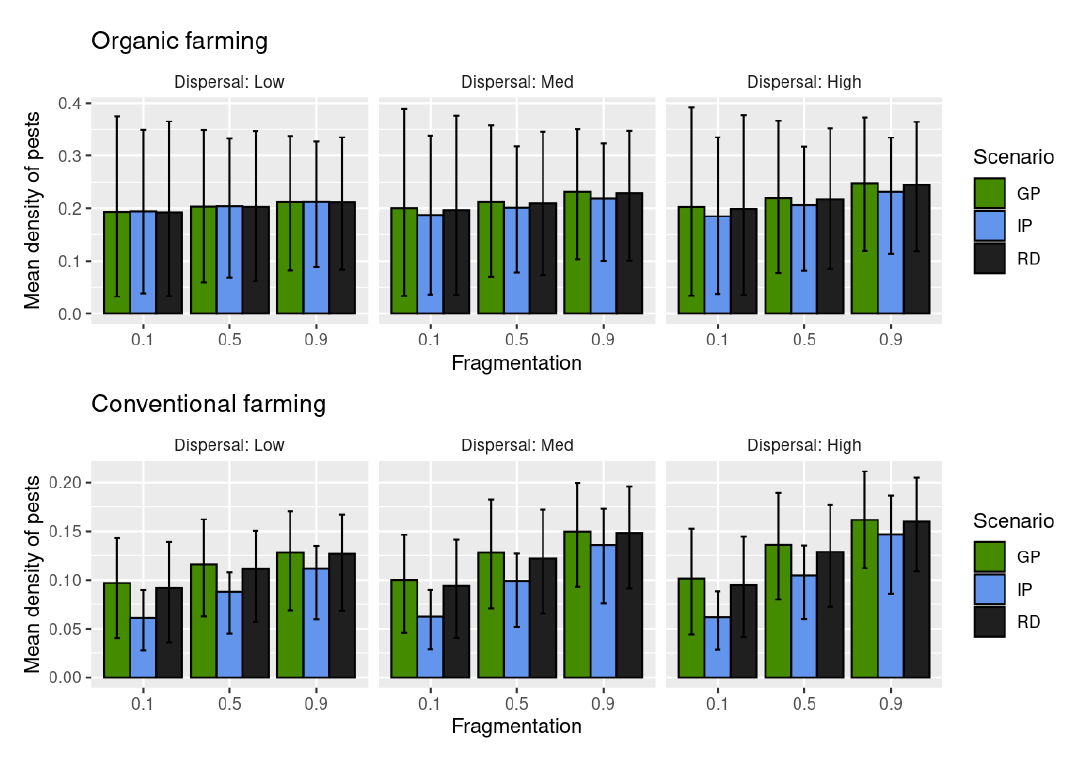
Figure S3 . Mean density of pests as a function of pest dispersal, semi-natural habitat fragmentation and organic farming expansion